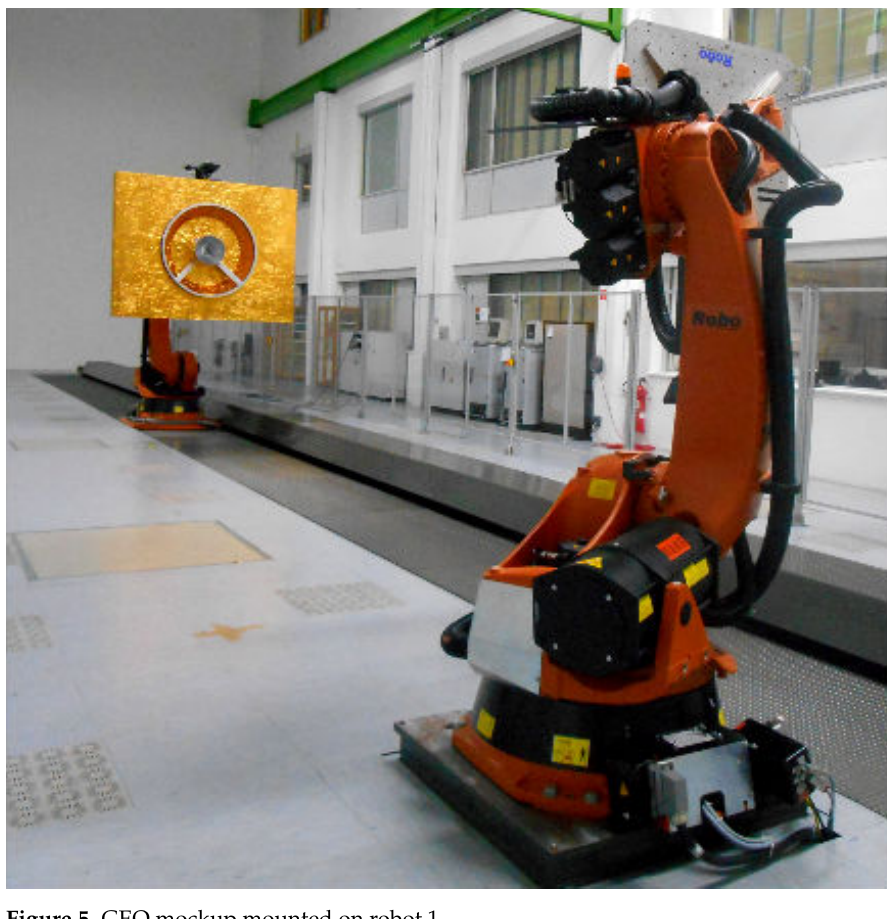
Figure 5. GEO mockup mounted on robot 1.